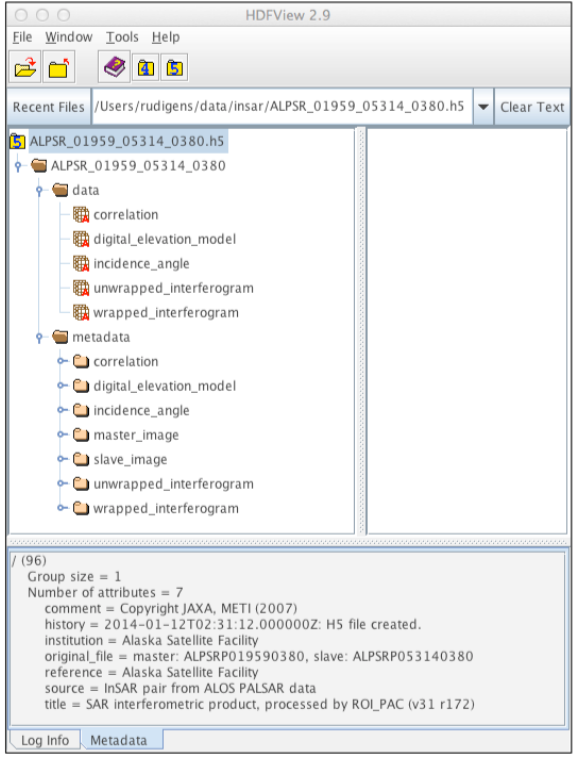
Figure 4. HDF5 Data and Metadata Structure as displayed in HDFView.